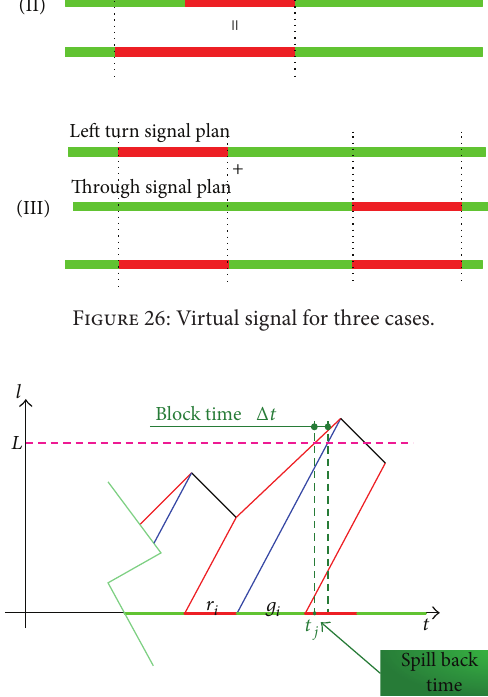
Figure 24: Wave profile when channelized section spillover exists.